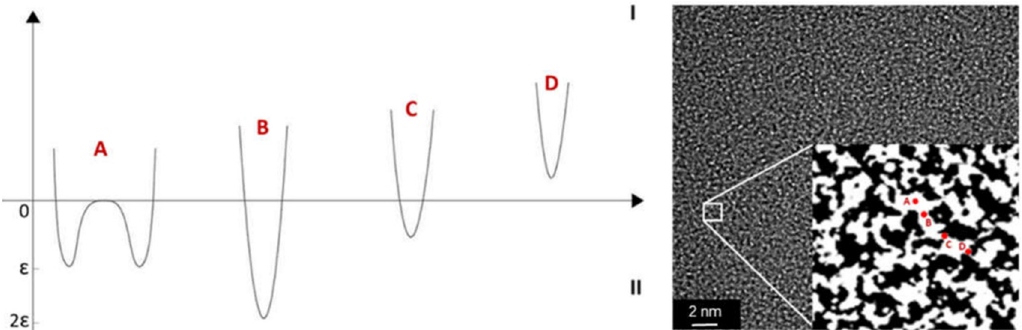
Figure 4. (I) Graphic representation of the gas molecules interaction within a pore or constriction. A .